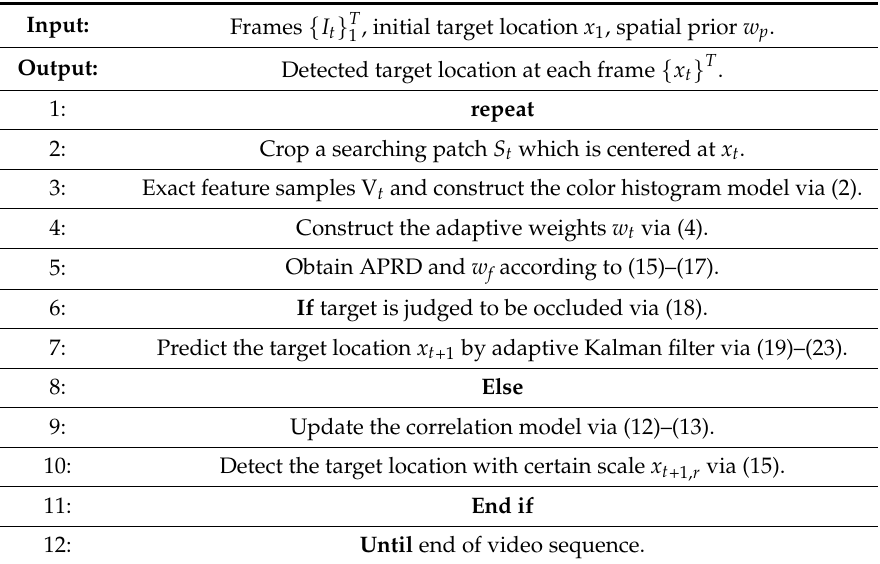
Table 1. The general flow of the whole FEDCF tracking